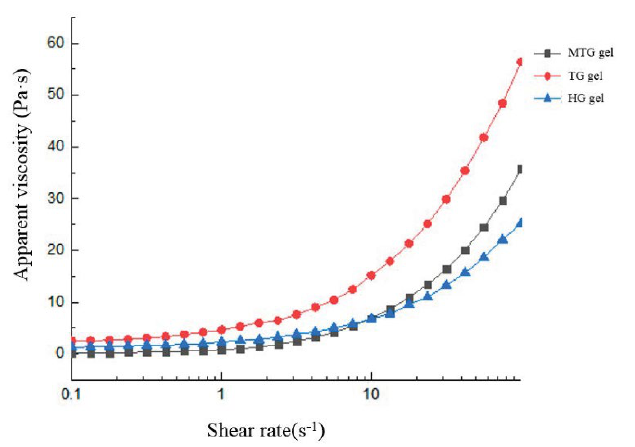
Figure 6. Flow behaviors (apparent viscosity versus shear rate) of HG gel, TG gel, and MTG gel at a protein concentration of 12% ( w / v